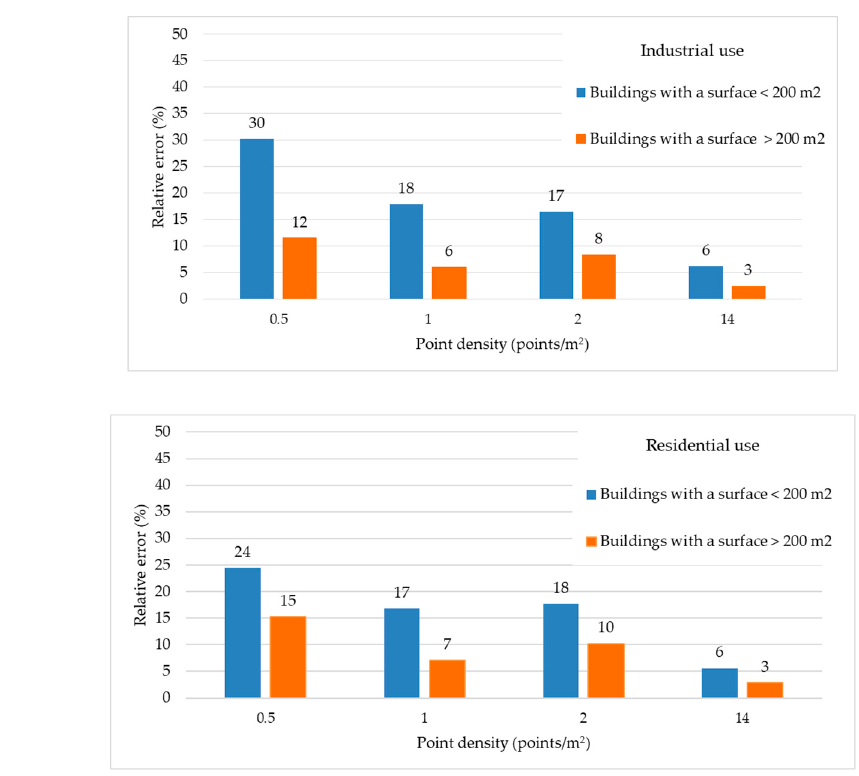
Figure 9. Mean relative error (%) for buildings with a surface <200 m 2 and > 200 m 2 : ( a ) industrial use ( b ) residential use.